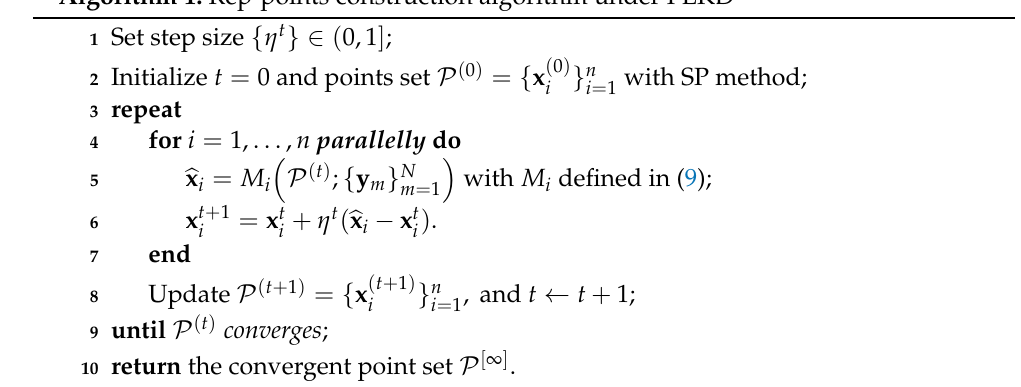
Algorithm 1: Rep-points construction algorithm under